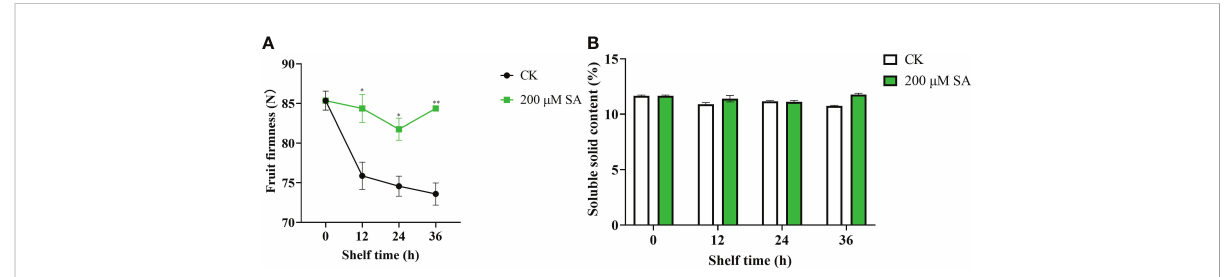
FIGURE 7 Fruit fi rmness (A) and soluble solids (B) contents in pear fruit after SA treatment at room temperature. The mean values and standard errors (bar) from three independent experiments are shown. Independent t tests for equality of means demonstrated signi fi cant (* p value < 0.05) or very signi fi cant (** p value < 0.01) differences between the control and treated